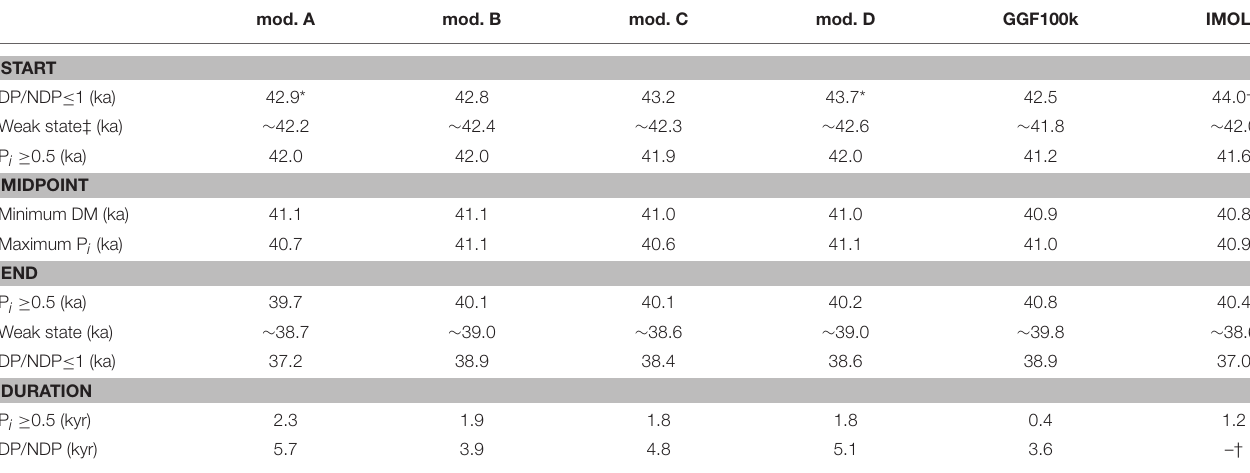
TABLE 2 | Global age (start, mid-point, end) and duration of the Laschamp excursion in the six models considered in this study. mod. A mod. B mod. C mod.